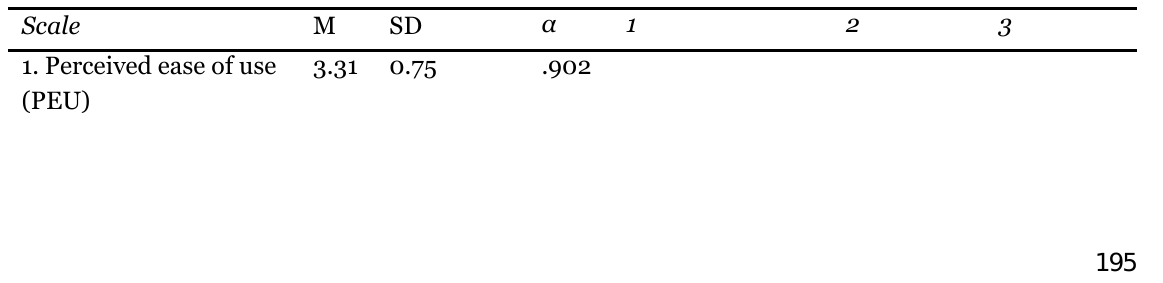
Correlation Matrix of TAM, Satisfaction and Training